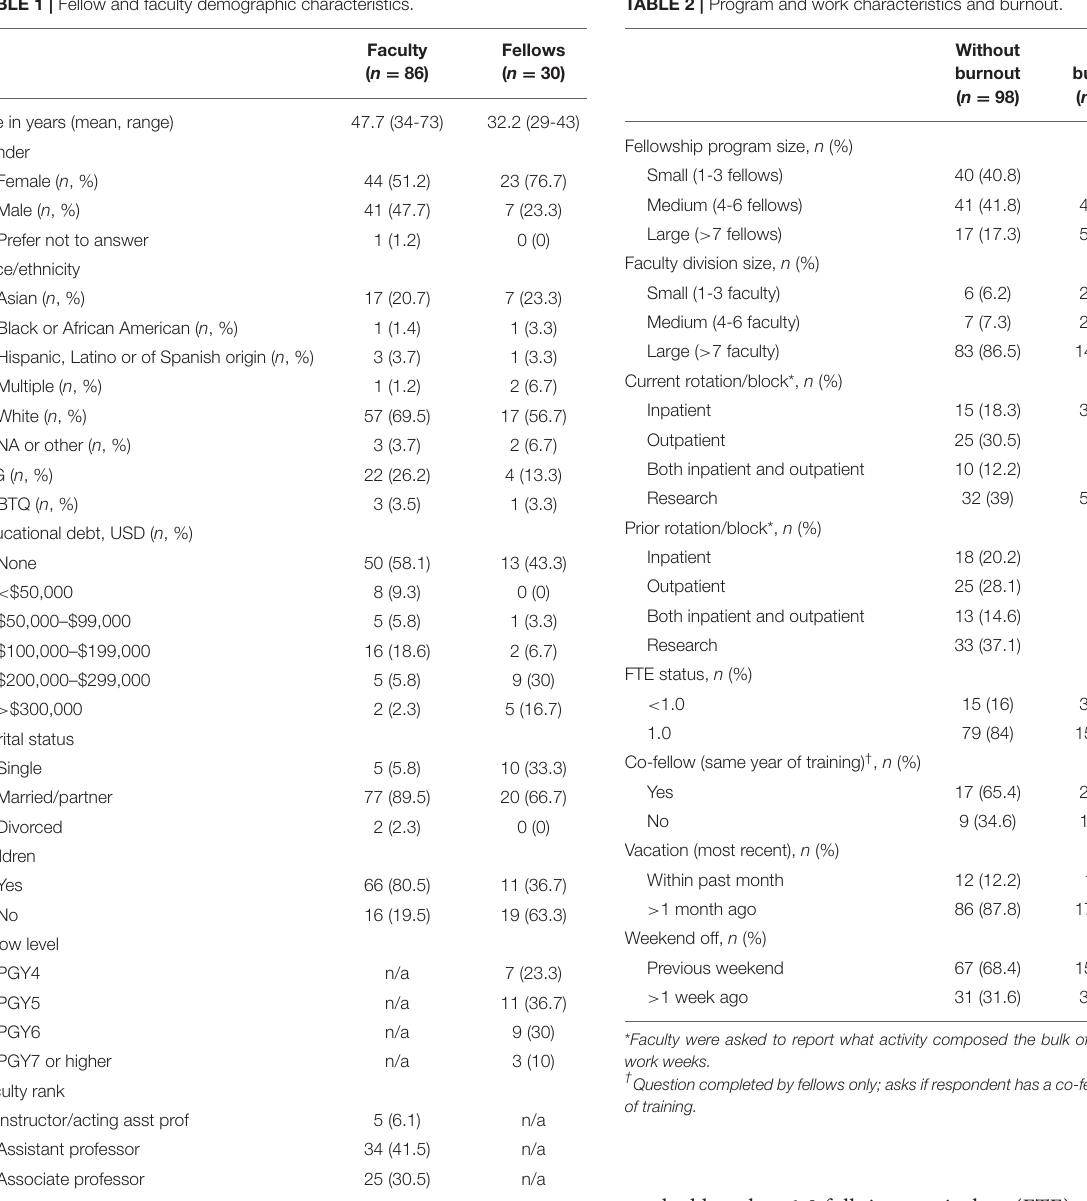
TABLE 1 | Fellow and faculty demographic